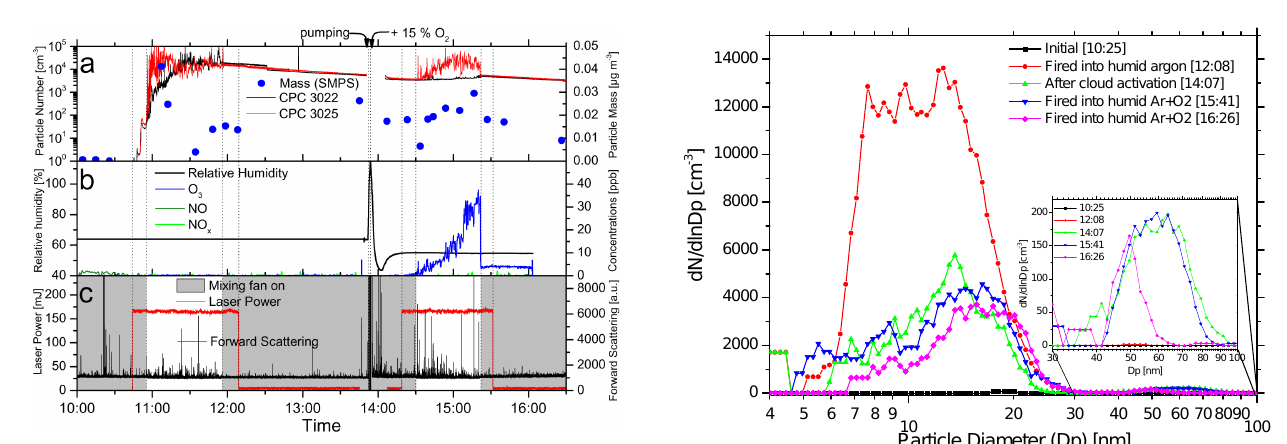
Fig. 3. Particle size distributions for selected times during experi- ments 1&2 in pure argon and in an argon–oxygen mixture (15% O 2 ) at 283K and at 64% as well as 55% relative humidity, respec- tively. Times in the legend refer to Fig.